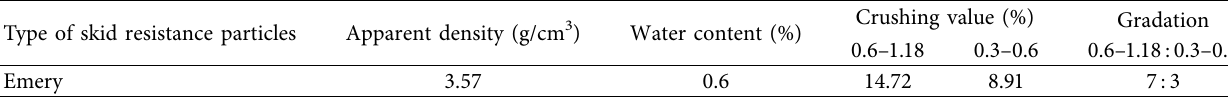
Table 4: The technical properties of the skid resistance particles.